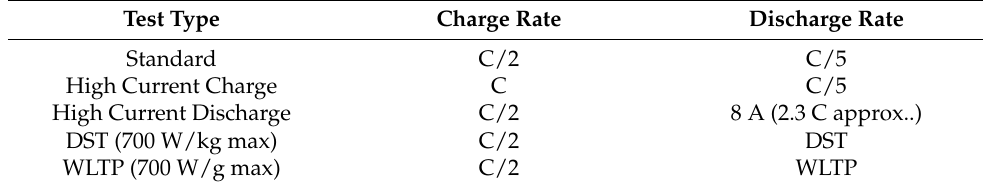
Table 2. Cycling tests applied to different